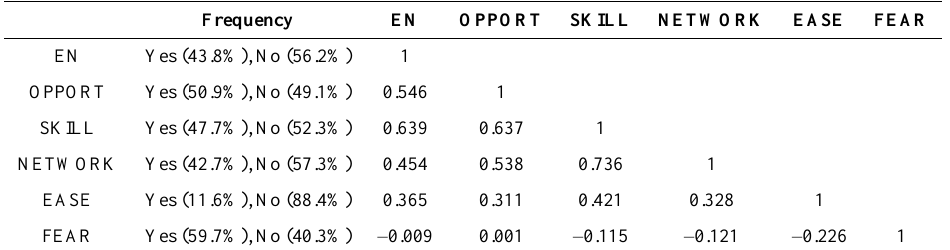
Table 3. Tetrachoric Correlations between Entrepreneurial Cognition Variables